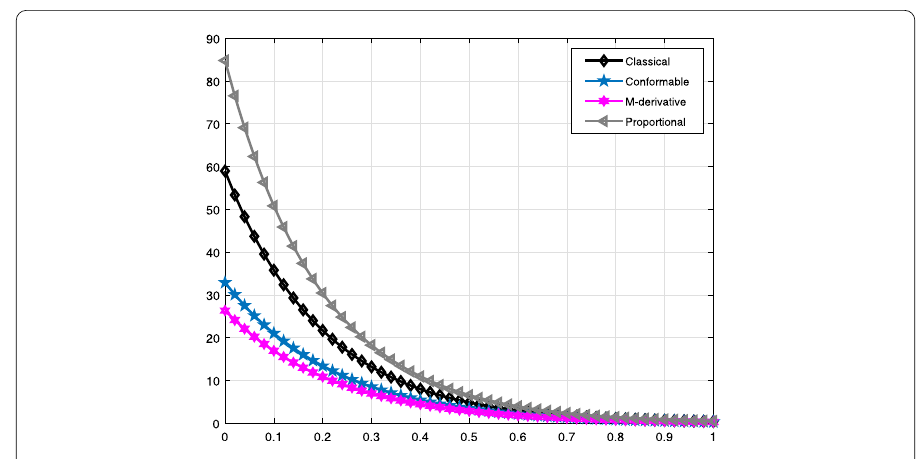
Figure 12 Comparative analysis when α = 0.98 and β = 0.96 for V e ( t )